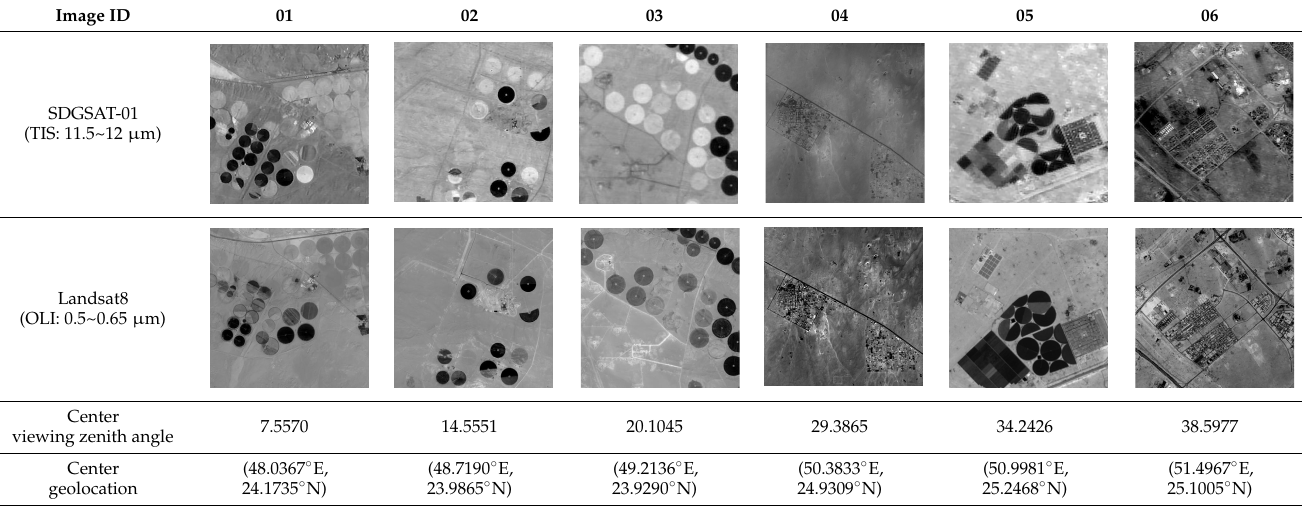
Table 2. The viewing zenith angle and the geolocation of the experiment images.